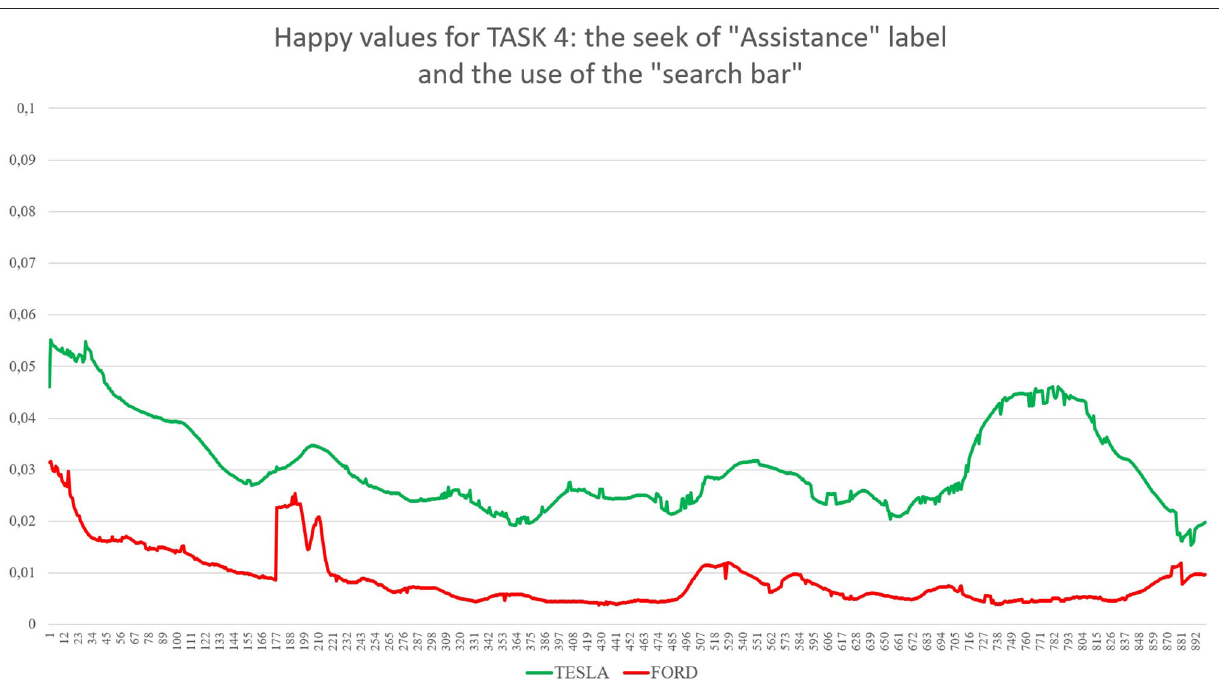
Frontiers in Psychology |